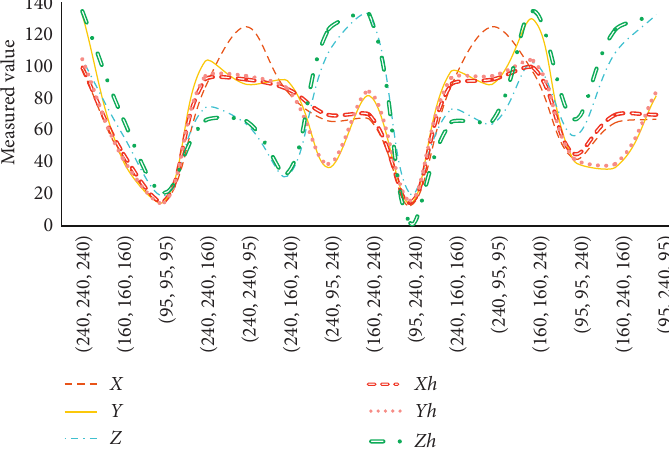
Figure 6: Measured and calculated values of X , Y , and Z of HSI with different combinations of